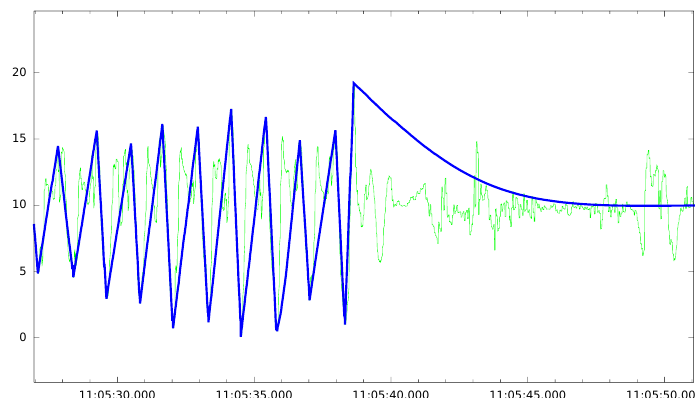
Figure 5. Graphical representation of the ground truth (thicker and darker line) over the signal of the vertical component of acceleration in the phone (thinner and clearer